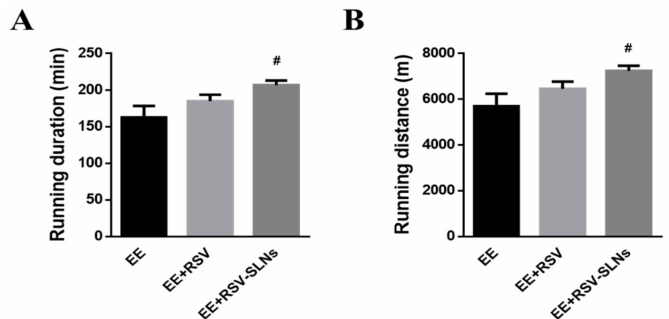
Figure 4. E ff ect of RSV-SLNs on running exhausted time ( A ) and running distance ( B ) of mice. Data are expressed as mean ± SD of six mice in each group. # p < 0.05 compared with EE group. EE: exhaustive exercise group; EE + RSV: exhaustive exercise combined with resveratrol supplementation; EE + RSV-SLNs: exhaustive exercise combined with RSV-SLNs supplementation.